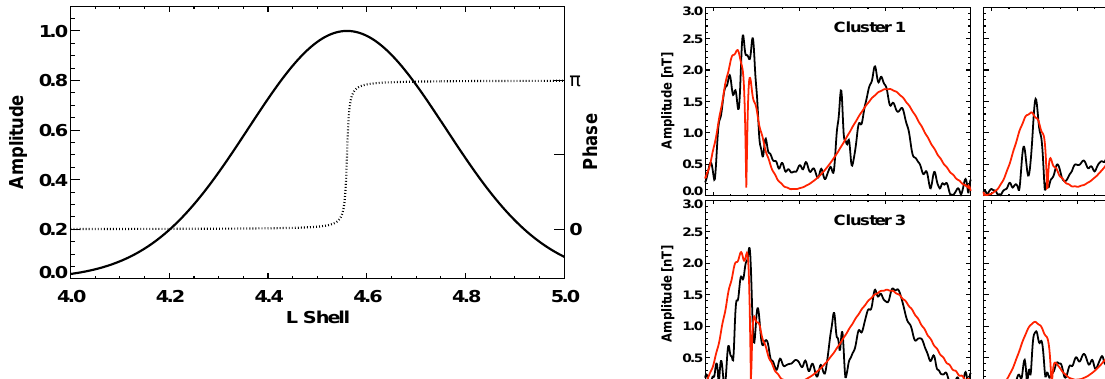
Fig. 11. Radial profile of the wave amplitude (thick line) and phase shift (dotted line).